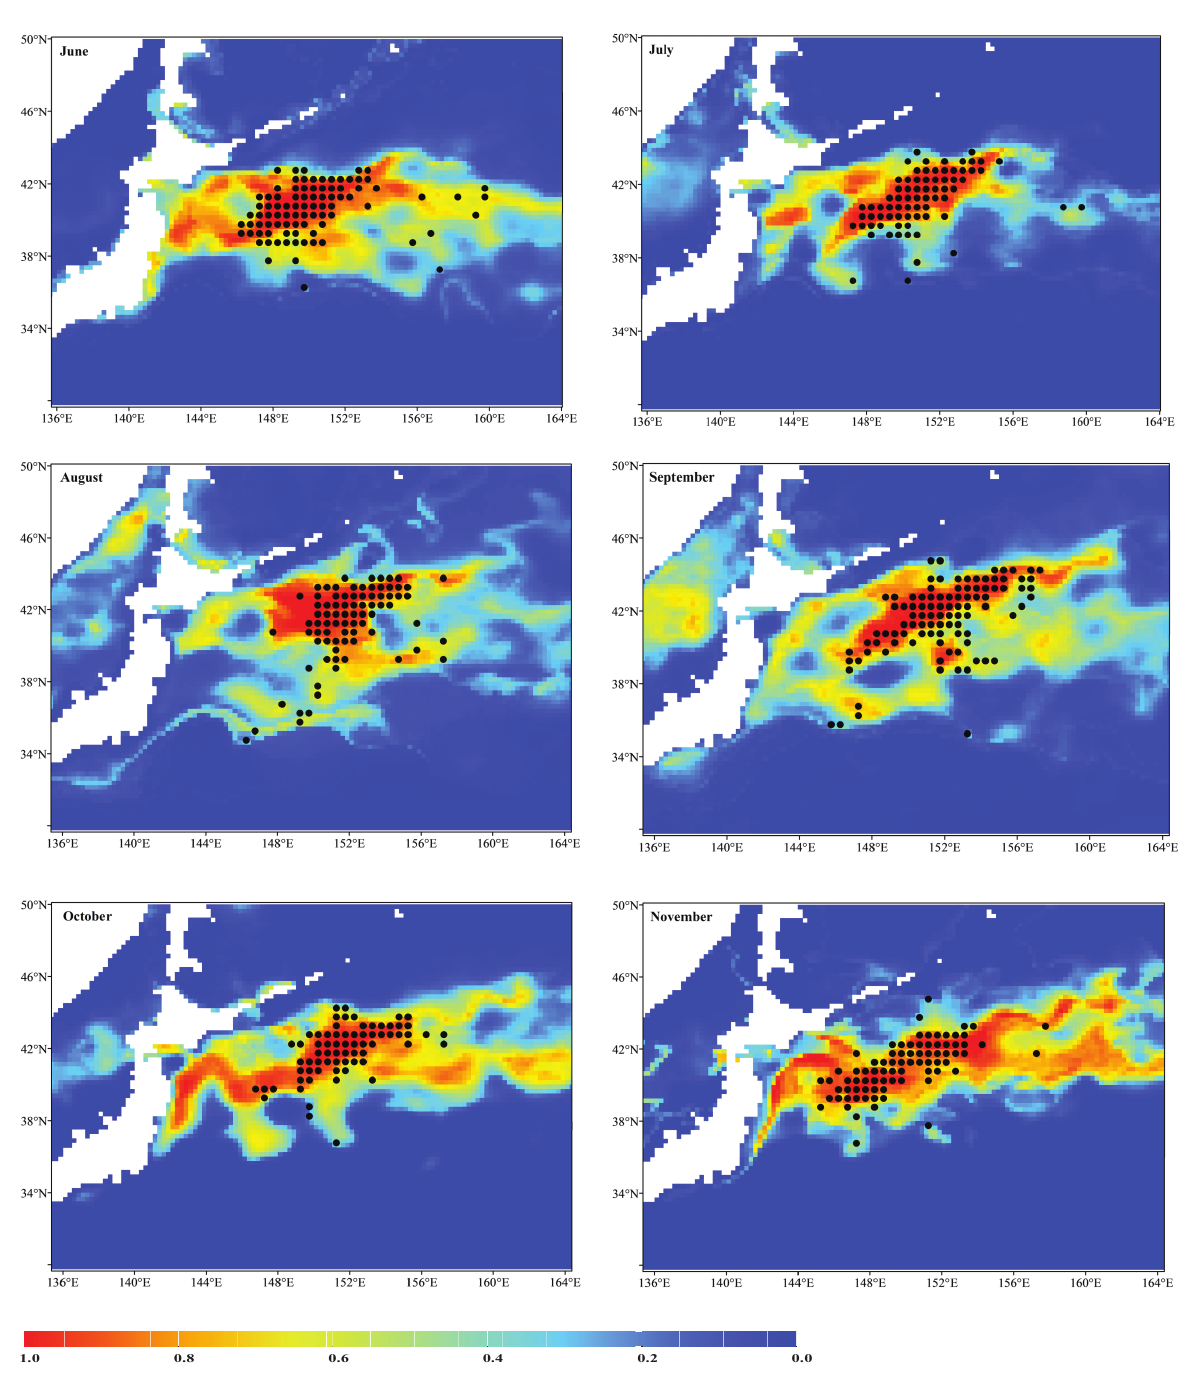
Figure 5. Distribution of the Pacific sardine potential habitats simulated using the ensemble models between June and November from 2015 to 2020 in the NPO. The black points represent the operation positions of the Pacific sardine fishing grounds.